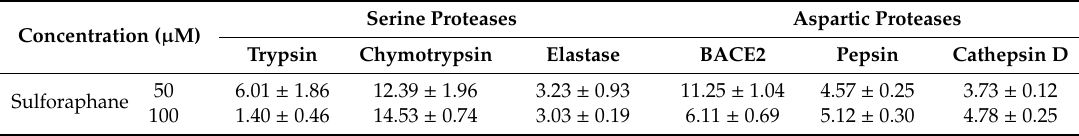
Table 2. Inhibitory activity (%) 1 of sulforaphane against serine and aspartic proteases. Serine Concentration ( µ M)